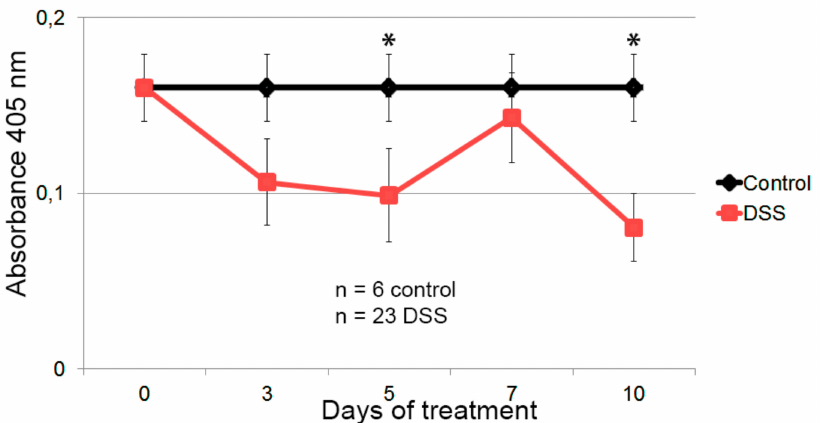
Figure 5. Detection of anti-HSP60 autoantibody in the sera of the healthy and DSS-colitic mice. Healthy mice are represented in black, and in red are mice treated with DSS in the drinking water for 7 days. The levels of anti-HSP60 autoantibodies in the control group has been defined as the average value of all the mice in the control group, including the values of the DSS-treated colitic mice at time 0. Mean and standard error of the mean are shown, as well as those significant results according to the Mann–Whitney U nonparametric test (* p ≤